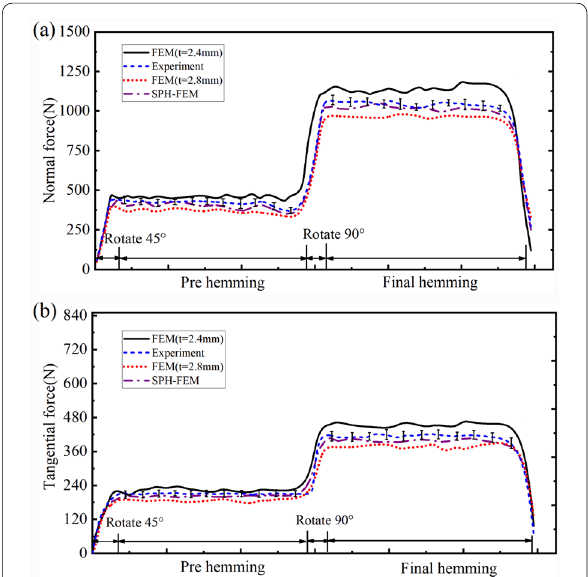
Figure 8 Evolution of external force on concave edge structure by experiment and simulation: (a) Normal force, (b) Tangential force